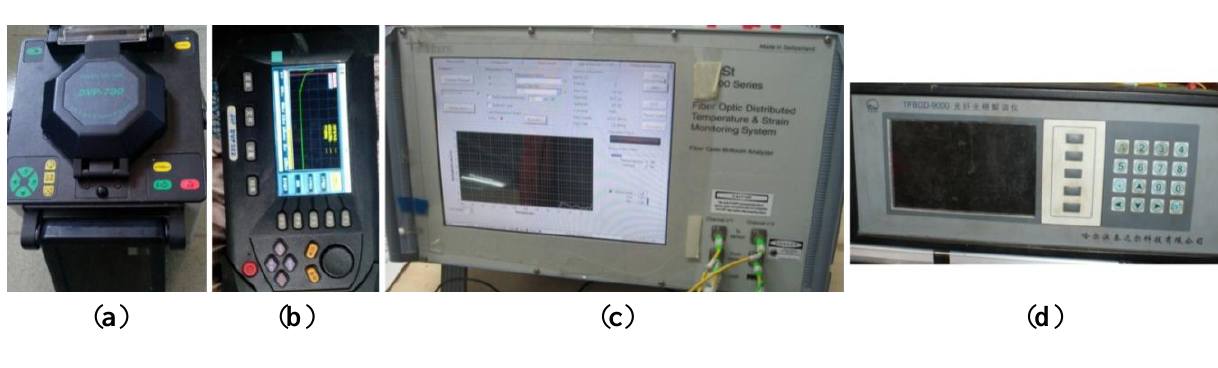
Figure 1. Equipment used in optical fiber sensing experiments. ( a ) Fusion